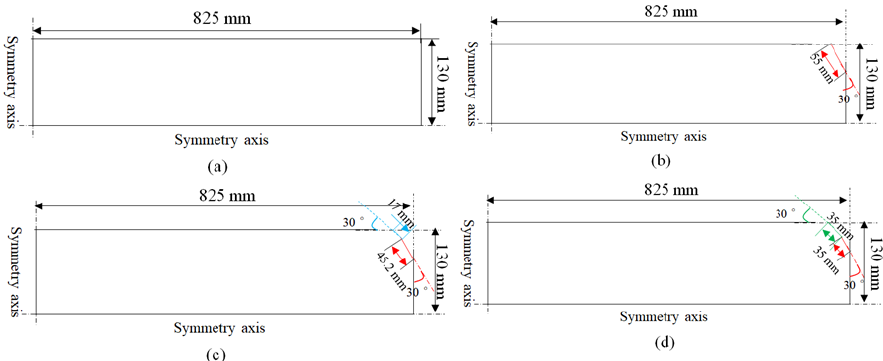
Figure 6. The geometrical dimensions of four corner-shape slabs: ( a ) RS; ( b ) OCS; ( c ) STCS; ( d ) LTCS.